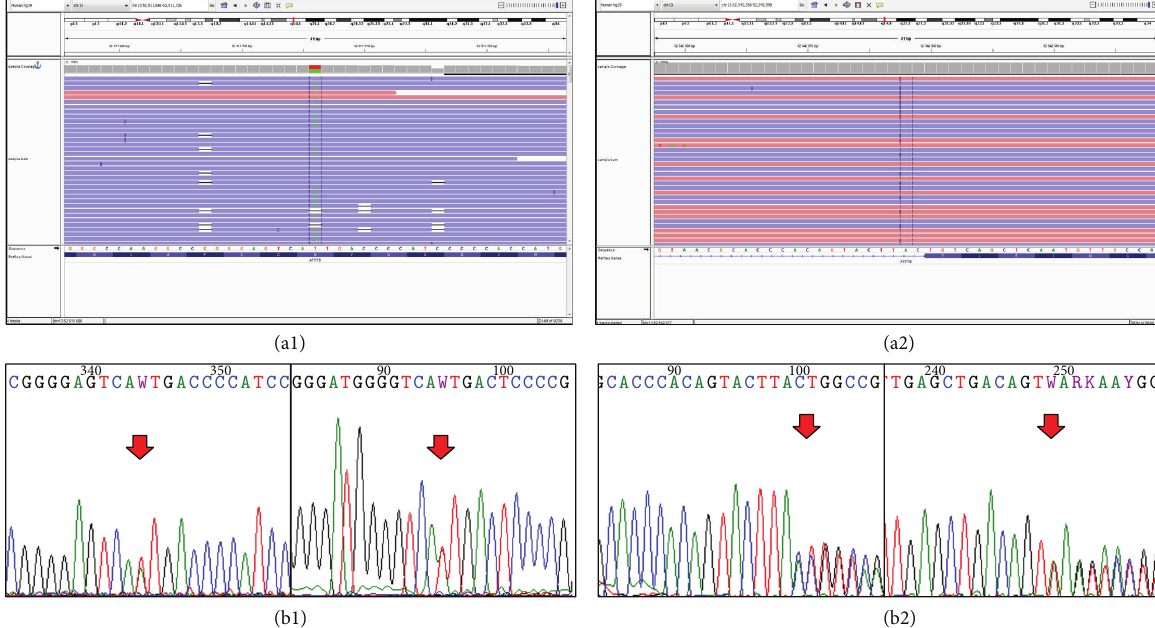
Figure 1: The identified mutations of patient 5. Both c.3809A > T (causing amino acid change p.Ala1270Ile) and c.1707+2dupT mutations are confirmed by Sanger-sequencing. The 3809A > C and A > G mutations are known, but the A > T substitution is a novel alteration at this position. (a1) Visualizing the alignment of the sequencing reads covering the ATP7B c.3809A > T heterozygous point mutation. The coverage was 400-fold (211-fold reference and 189-fold variant coverage). (b1) Validating our finding with Sanger sequencing, red arrow indicates the position of the point mutation. The mutation is present in both directions. (a2) Visualizing the alignment of the sequencing reads covering the ATP7B c.1707+2dupT heterozygous insertion mutation. The coverage was 399-fold (188-fold reference and 211-fold variant coverage). (b2) Validating our finding with Sanger-sequencing, red arrow indicates the position of the insertion. The mutation is present in both directions.